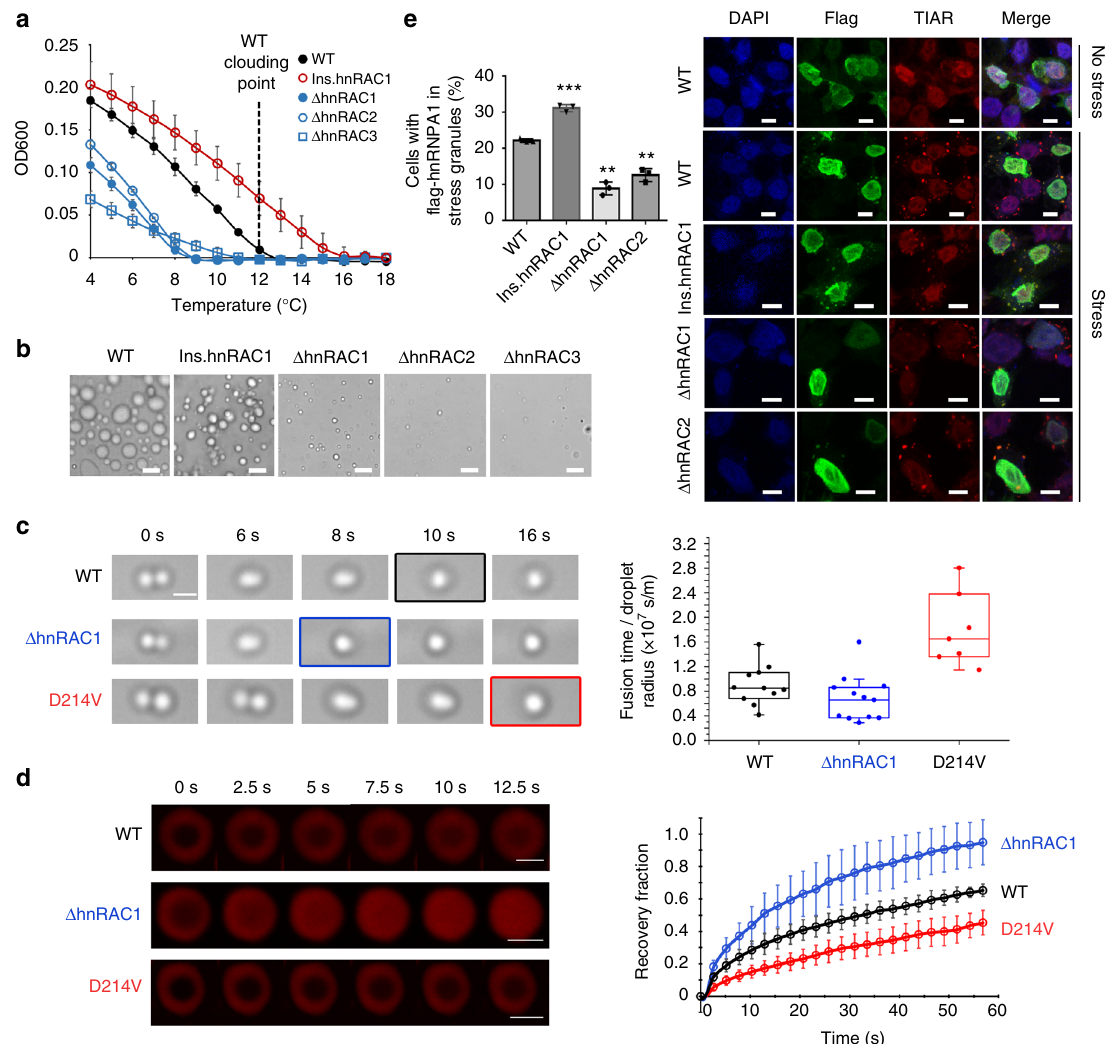
Fig. 5 The role of reversible amyloid formation in hnRNPA1 phase separation and stress-granule assembly. a Phase diagram measurements of hnRNPA1 variants. The dashed line indicates the clouding point of WT (the temperature at which droplets emerge). Data shown are means ± s.d., with n = 3 individual experiments. WT wild type, ins insertion, Δ deletion. Source data are provided as a Source Data fi le. b Representative DIC images of liquid-like droplets formed by hnRNPA1 variants at 6 °C. Scale bars are 10 μ m. c Effects of reversible amyloid formation on the fl uidity of liquid-like droplets measured by optical tweezers. Montages show representative processes of droplet fusion. The boxplot shows the fusion time of droplets divided by mean drop radius. The line within the boxplot indicates the median. Edges of the boxes are the 25th and 75th percentiles. The whiskers extend to outliers. Source data are provided as a Source Data fi le. d Effects of reversible fi bril formation on the mobility of liquid-like droplets by FRAP. Montages show the processes of droplet recovery after photobleaching. The graph on right shows the recovery fraction as the function of time. Data shown are means± s.d., with n = 5 individual droplets. The time point right after photobleaching is set to 0. Source data are provided as a Source Data fi le. Scale bars are 2.5 μ m. e Recruitment of hnRNPA1 variants into stress granules. DAPI stains the nucleus. HnRNPA1 fused with a Flag-tag was overexpressed in HeLa cells and localized in the nucleus. In response to stress, hnRNPA1 was released to the cytosol and involved in stress granules. TIAR is a marker protein for stress granules. Stress was applied by addition of 0.5 mM sodium arsenate. Scale bars are 10 μ m. The bar graph on left shows the percentage of cells with fl ag- tagged hnRNPA1 in stress granules. Approximately 300 cells from 15 images were calculated for each variant. Errors are s.d. of three